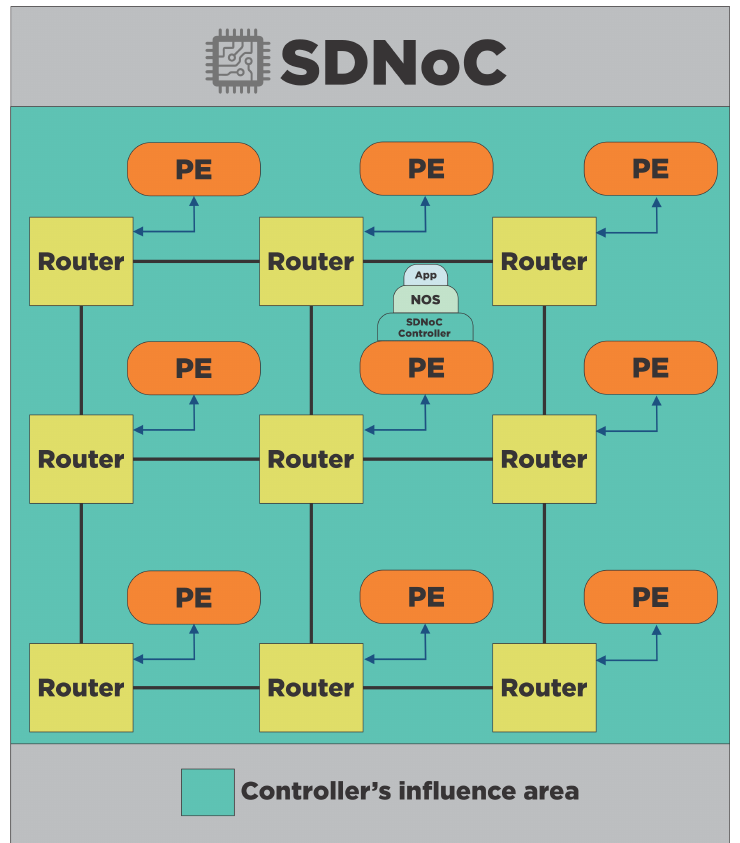
Figure 5. Centralized implementation of an SDNoC architecture. The illustration shows the SDNoC controller’s influence area, all the NoC, in this case. A single CPU execute all the software